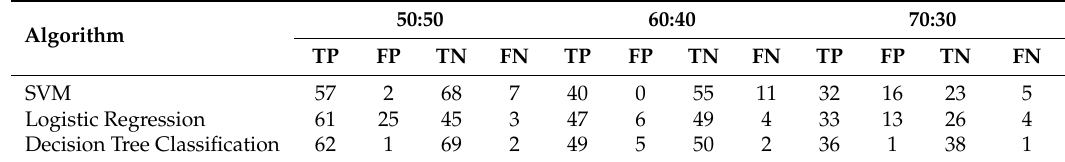
Table 1. Performance evaluation of the di ff erent classification algorithms on varying training / test sizes.